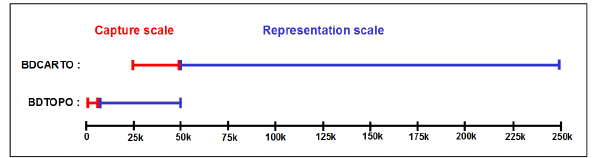
Figure 3. Capture scale-range and representation scale-range